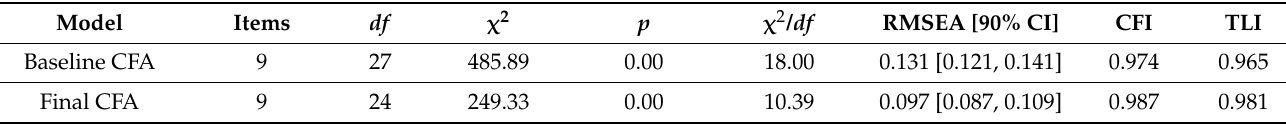
Table 2. Summary of CFA Fit Results for Religious/Spiritually Integrated Practice Assessment Scale-Client Attitudes v2